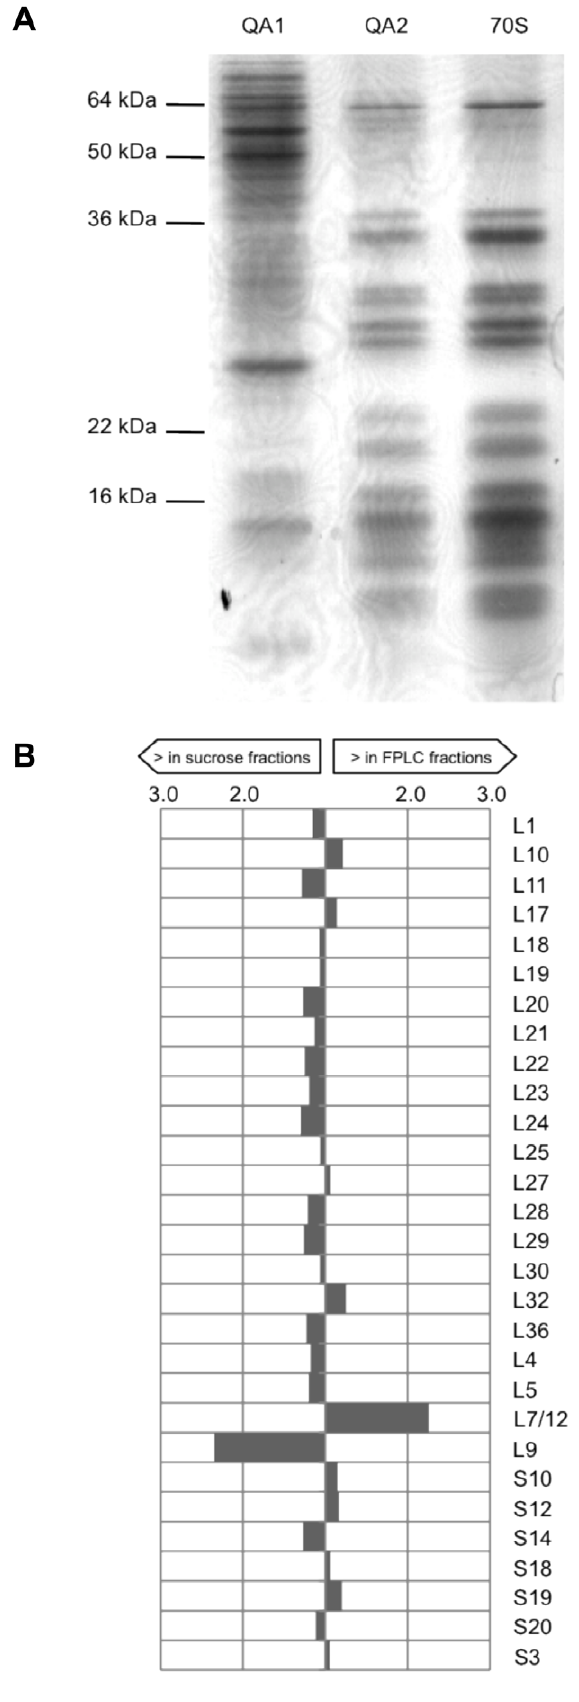
Figure 2. Chromatographic fraction QA2 and sucrose-purified ribosomes contain comparable levels of ribosomal proteins. ( A ) Proteins from QA1 and QA2 were precipitated and compared to sucrose-purified ribosomes (70S) by SDS-PAGE. ( B ) Sucrose-gradient purified ribosomal samples and chromatography-purified ribosomal samples were analysed by iTRAQ coupled to HPLC-MSMS. The relative abundance of ribosomal proteins whose levels varied between the two preparations is